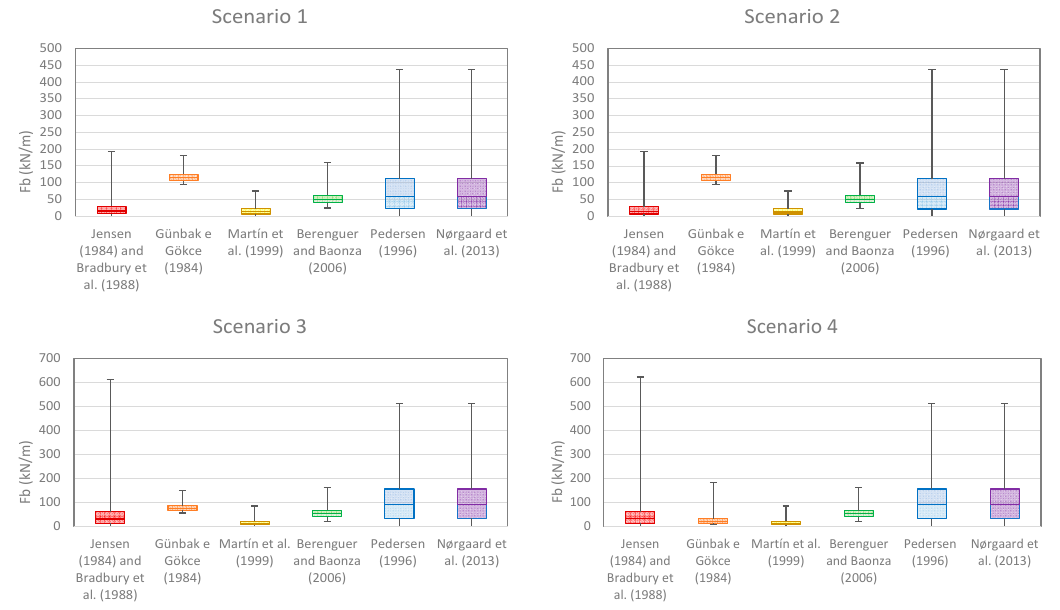
Figure 24. Results of Fb for the different formulas for scenarios 1 to 4. Moments present the same trend as forces, for the reasons presented before. Safety coefficients C des (sliding) and C der (overtuning) present a small reduction between scenar- ios 1 and 2. This was expected, since the sea level rise considered is small and leads to small differences in forces and momenta. However, this decrease was more accentuated